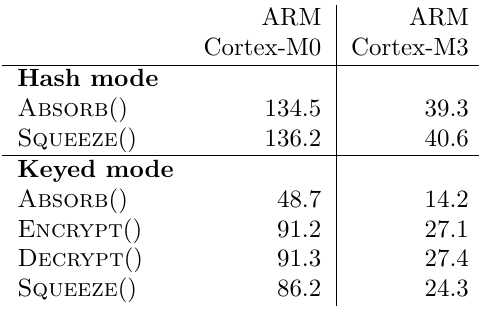
Table 4: Performance figures of Xoodyak in cycles per